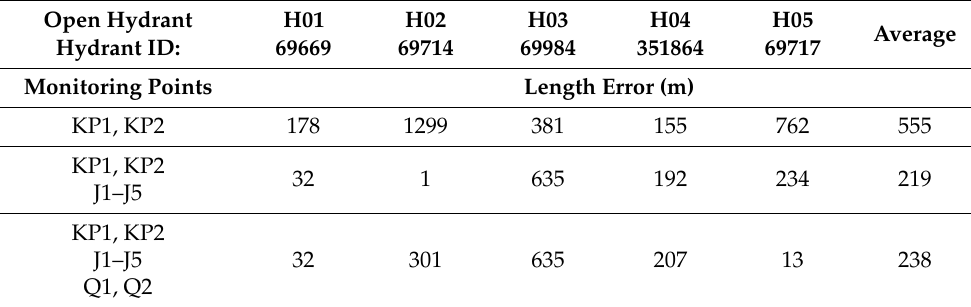
Table 4. Calculated length of the error of leakage indications in the analysed DMA zone.